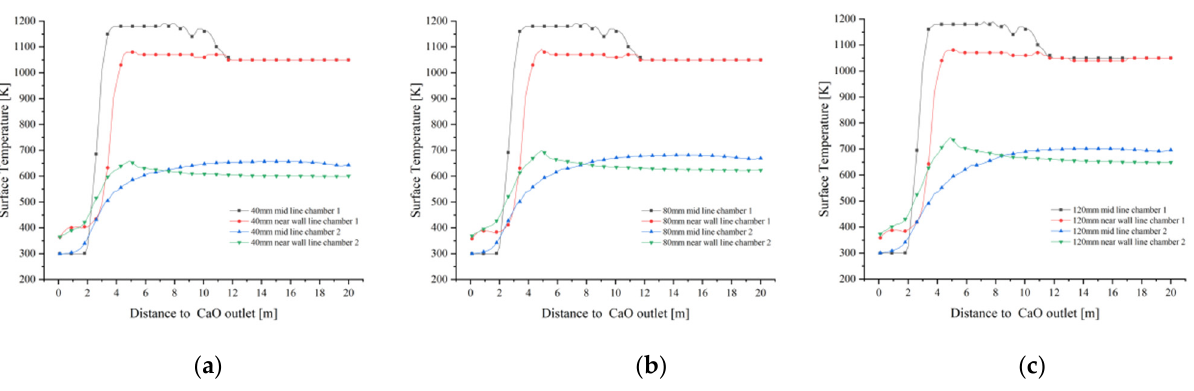
Figure 12. Variation of solid surface temperature on the mid lines and near wall lines for 40 mm, 80 mm and 120 mm particle sizes. ( a ) 40 mm solid surface temperature variation ( b ) 80 mm solid surface temperature variation ( c ) 120 mm solid surface temperature variation.